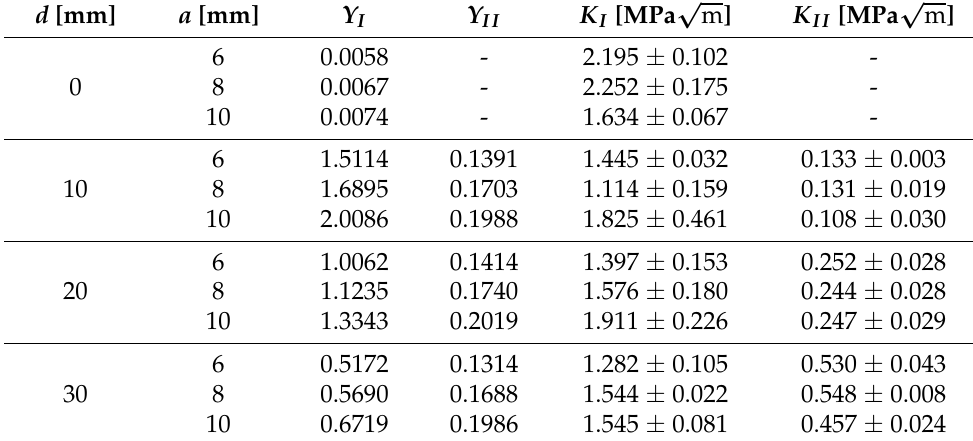
Table 5. Stress intensity factor in mode I and